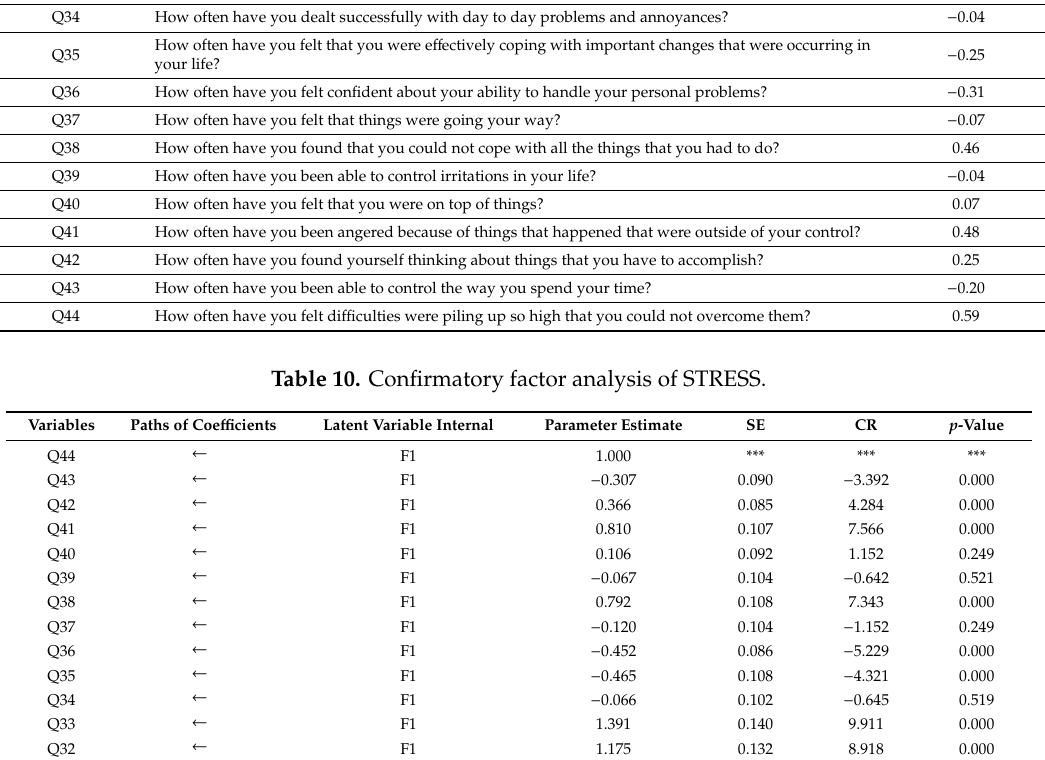
Table 10. Confirmatory factor analysis of STRESS.